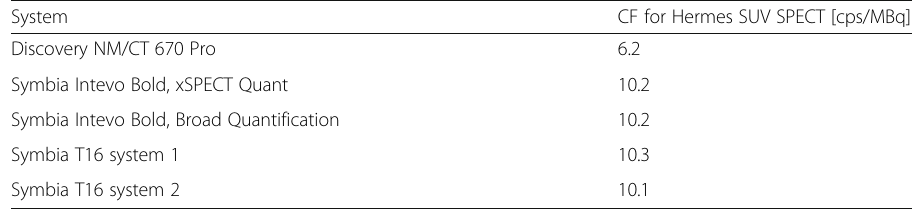
Table 4 Calibration factor (CF) for each system for vendor-neutral quantification System